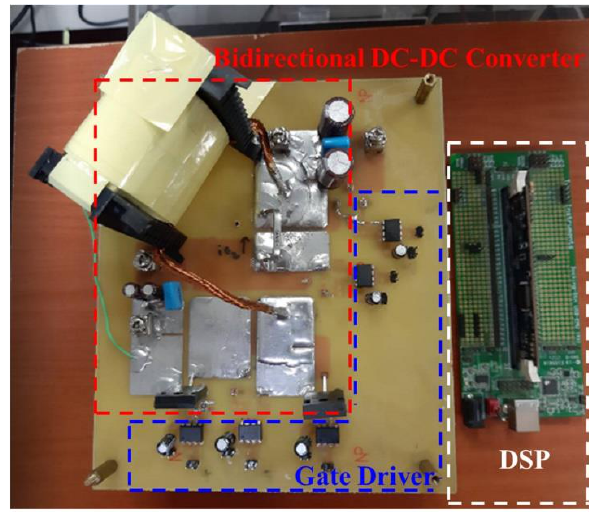
Figure 15. Photography of the experimental system.